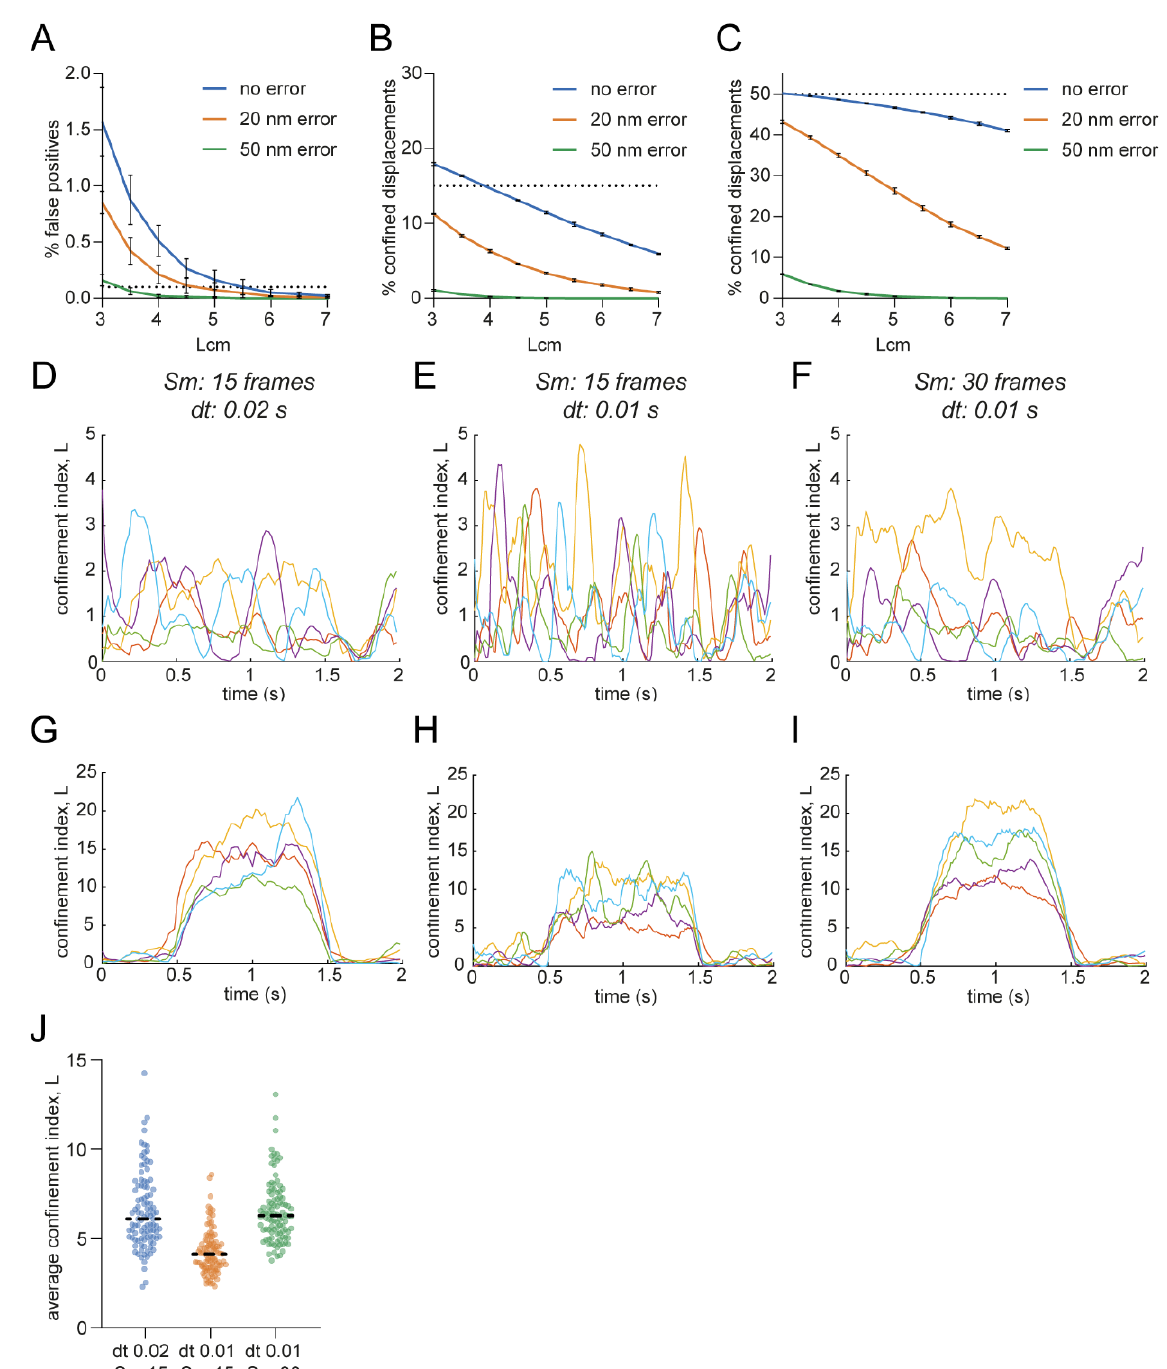
Figure 5. Influence of experimental parameters on confinement detection. ( A ) Effect of localization error on the percentage of false positives detected in random walks. Three independent simulations of 1000 trajectories per condition. Data are represented as means ± SD. ( B , C ) Effect of localization error on the percentage of detected confined displacements in tracks simulated to be confined for 15 ( B ) or 50 ( C ) of the 100 frames. Rconf = 0.04 µ m. Three independent simulations of 1000 trajectories. Data are represented as means ± SD. ( D – F ) Confinement index of 5 random trajectories over time with ( D ) Sm = 15, dt = 0.02 s and 100 frames, ( E ) Sm = 15, dt = 0.01 s and 200 frames, ( F ) Sm = 30, dt = 0.01 s and 200 frames. ( G – I ) Confinement index of 5 confined trajectories over time with ( G ) Sm = 15, dt = 0.02 s and 100 frames, ( H ) Sm = 15, dt = 0.01 s and 200 frames, ( I ) Sm = 30, dt = 0.01 s and 200 frames. Rconf = 0.04 µ m. ( J ) Corresponding average confinement index values of ( G – I